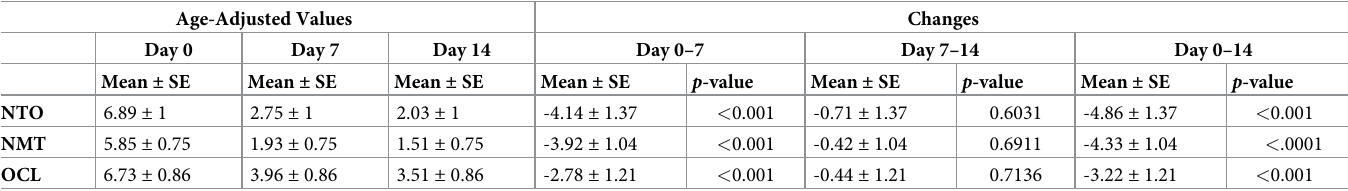
Table 1. Age-adjusted mean UD scores and differences in mean UD